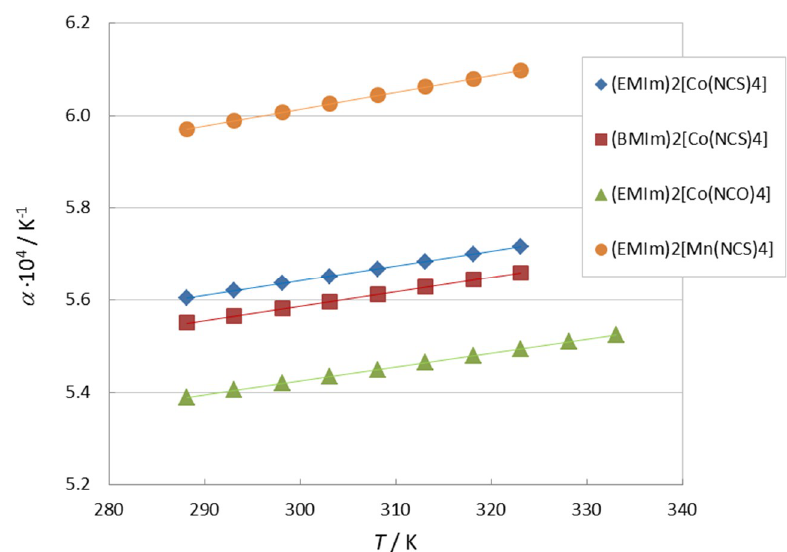
Figure 6. Isobaric coe ffi cient of thermal expansion of (EMIm) 2 [Mn(NCS) 4 ] (sample I, orange dots / line) compared to (EMIm) 2 [Co(NCS) 4 ] [25] (blue squares / line) and (EMIm) 2 [Co(NCO) 4 ] [34] (green triangles / line).